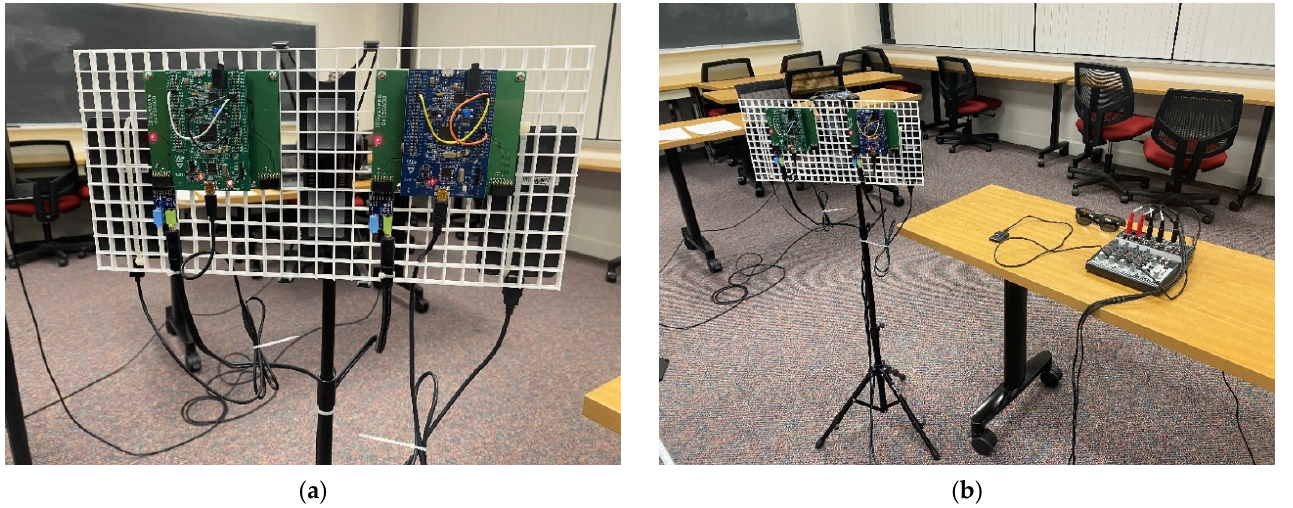
Figure 11. Actual eyeglass receiver device realization: ( a ) Dual channel receiver hardware; ( b ) Overall eyeglass receiver device hardware.